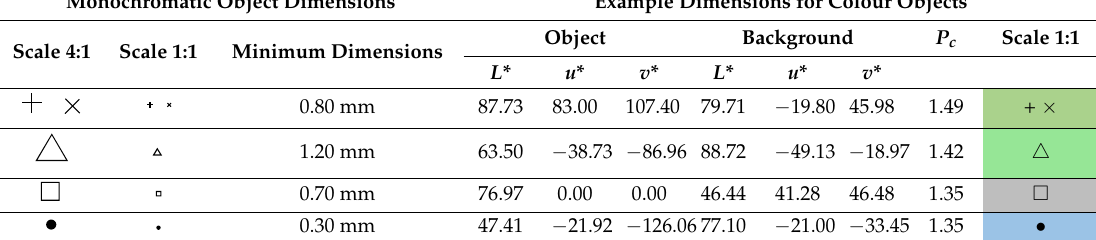
Table 3. On the left are minimum dimensions of achromatic objects proposed by the Swiss Cartographic Society [29], while on the right are colour components of L * u * v * colour space for the map symbol and its background, calculated perception coefficient and representation of the colour map symbol of colour on a 1:1 scale. Example Dimensions for Colour Objects